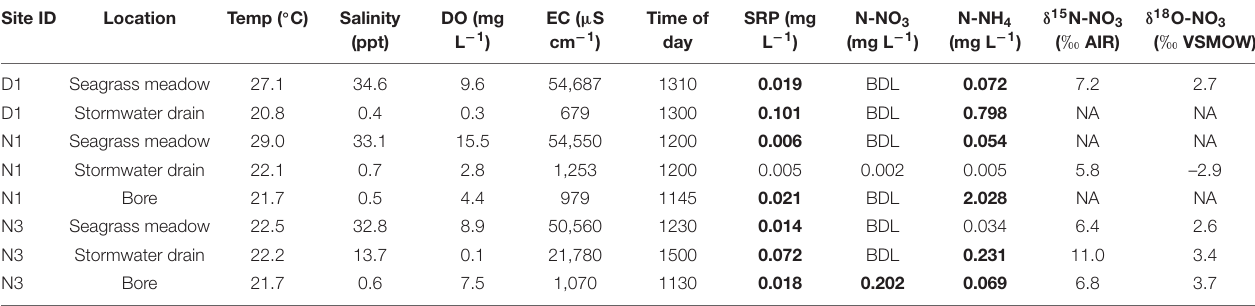
TABLE 1 | Water quality parameters of seagrass meadows, stormwater drains, and groundwater. Site ID Location Temp ( ◦